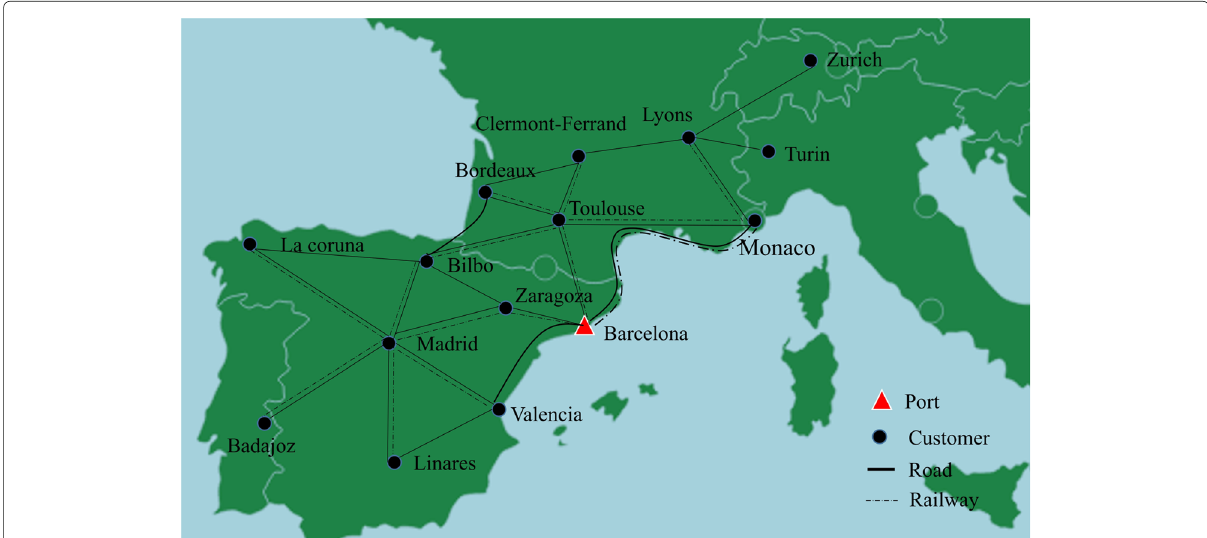
Fig. 9 Real transportation network of a transportation enterprise in part of southern